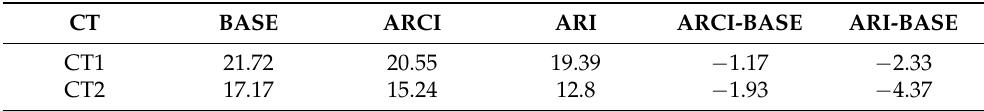
Table 1. Relative frequency of appearance (%) of CT1 and CT2 in each experiment. Difference between ARCI/ARI and BASE experiments.